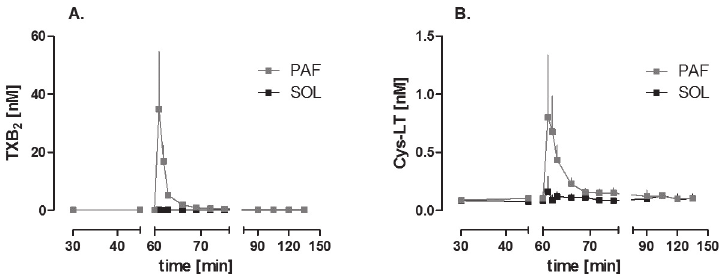
Fig 1. PAF-induced eicosanoid liberation to the vascular compartment. A. Concentration of thromboxane in the venous compartment of PAF-stimulated intestines (PAF, n = 3) and untreated intestines (SOL, n = 4); B. Concentration of cysteinyl leukotrienes in the venous compartment of PAF-stimulated intestines (PAF, n = 3) and untreated intestines (SOL, n =